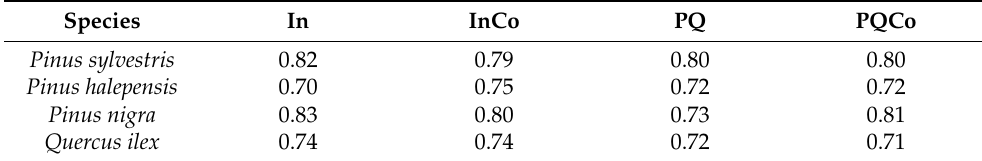
Figure 3. Linear regression line of expected versus observed tree size in the fourth National Forest Inventory (DBH4, mm) with the closest neighbour for aggregation levels (individual and plot-quantile classes), two Equations (1) and (2), and species ( Pinus sylvestris , P. halepensis , P. nigra , and Quercus ilex ). Table 3. Determination of coefficient r 2 of the linear model relating observed DBH vs. expected DBH at NFI4 with the closest neighbour for each aggregation level (individual (In) and plot-quantile classes (PQ)), Equations (1) and (2) (Co for competition), and species ( Pinus sylvestris , Pinus halepensis , Pinus nigra , and Quercus ilex